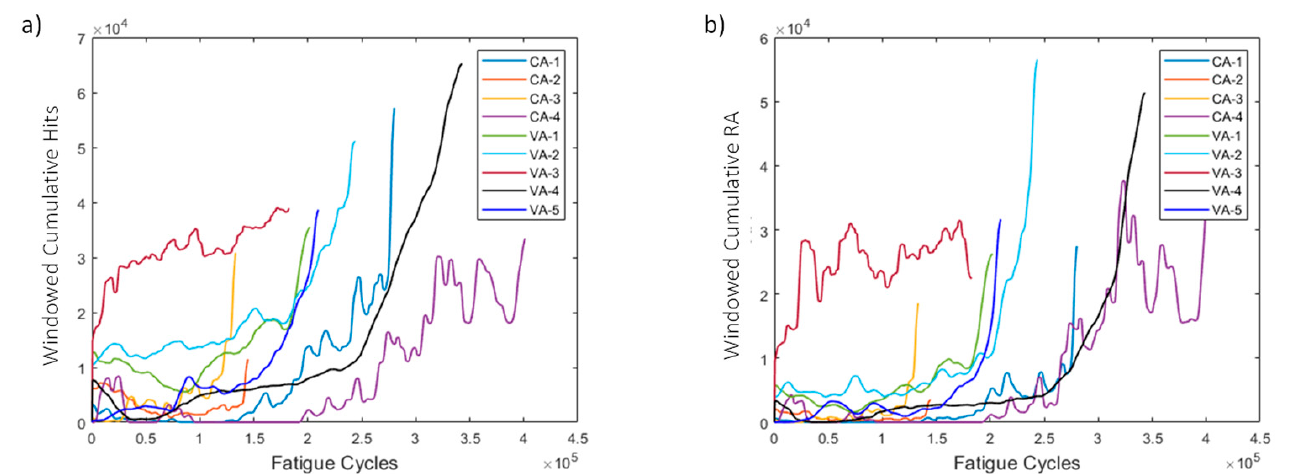
Figure 24. ( a ) Windowed cumulative hits and ( b ) windowed cumulative RA for all specimens.